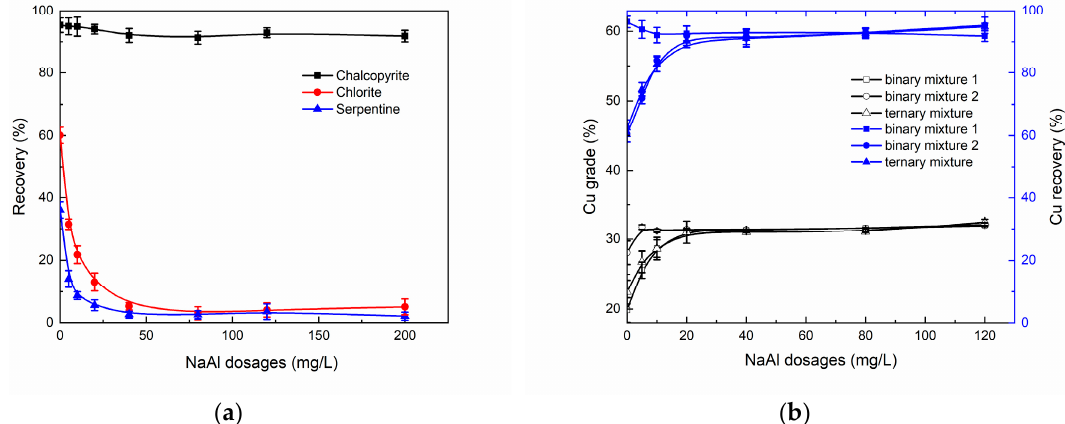
Figure 5. Effect of NaAl dosages on the flotation behavior of single minerals ( a ) and mixed minerals ( b ). [SAX] = 20 mg/L; [MIBC] = 20 mg/L; pH = 9.